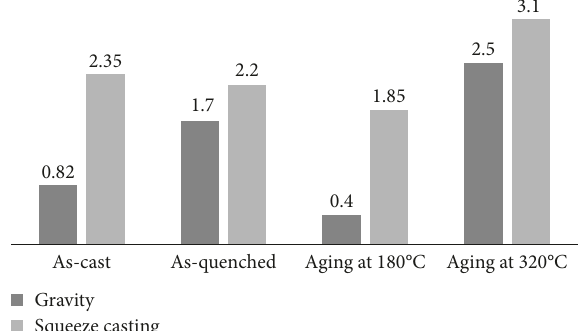
Figure 9: Elongation (%) of the gravity cast and the squeeze cast alloy under 90MPa pressure in the different treatment